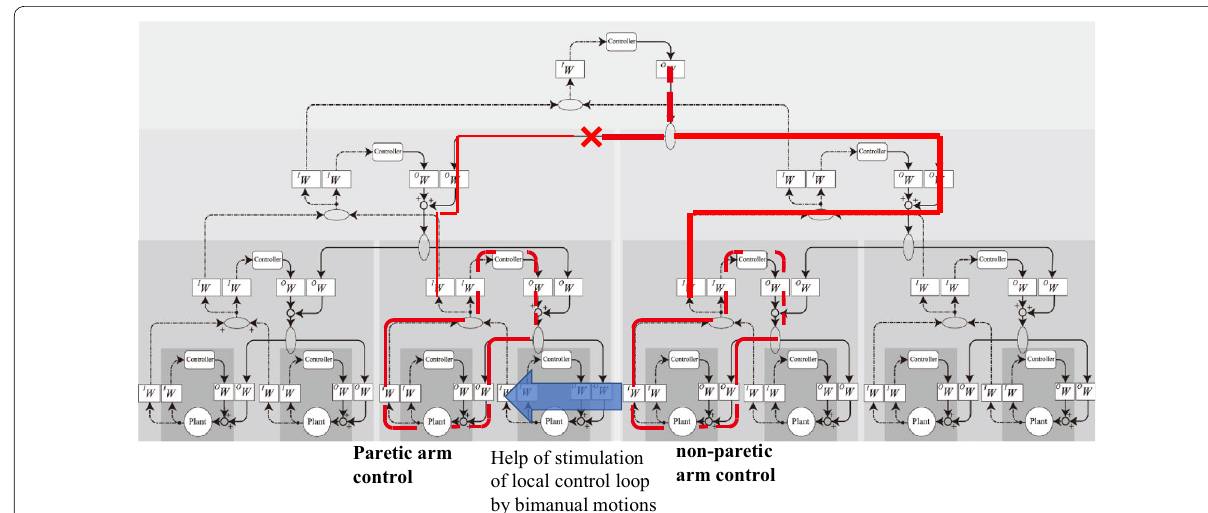
Fig. 10 The neuro-synergy system represents signal processing in a biological control system. In biological control systems, information acquired from the environment is gradually symbolized to reduce its dimensions, while control signals are created from this symbolized information to create behaviors. Motion paralysis is caused by weakened or diminished control signals. The results suggest that appropriate bimanual motion can help activate local control loops, resulting in proper muscle